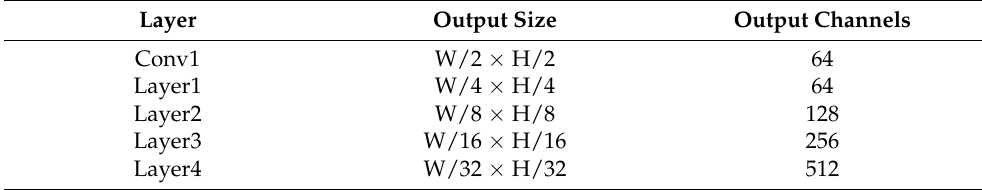
Table 2. The output feature map size and number of channels of each layer of